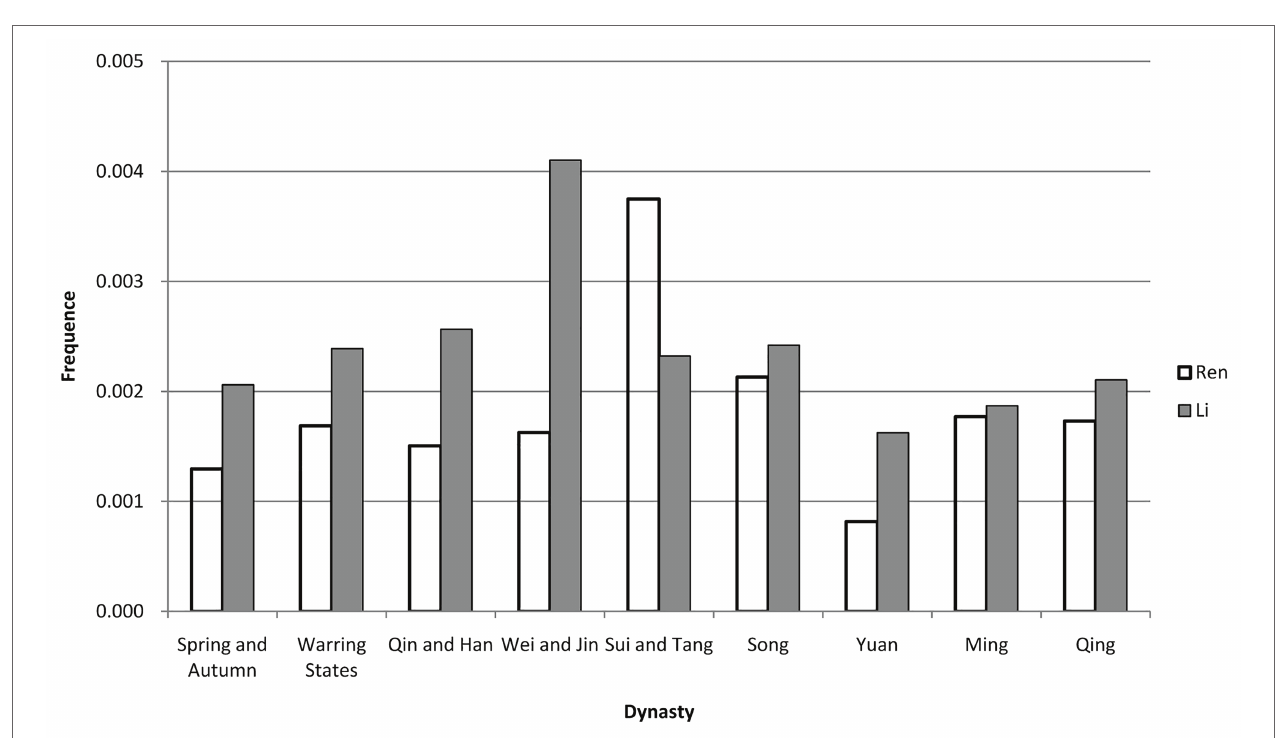
FIGURE 2 | Differences between “Ren” and “Li.”